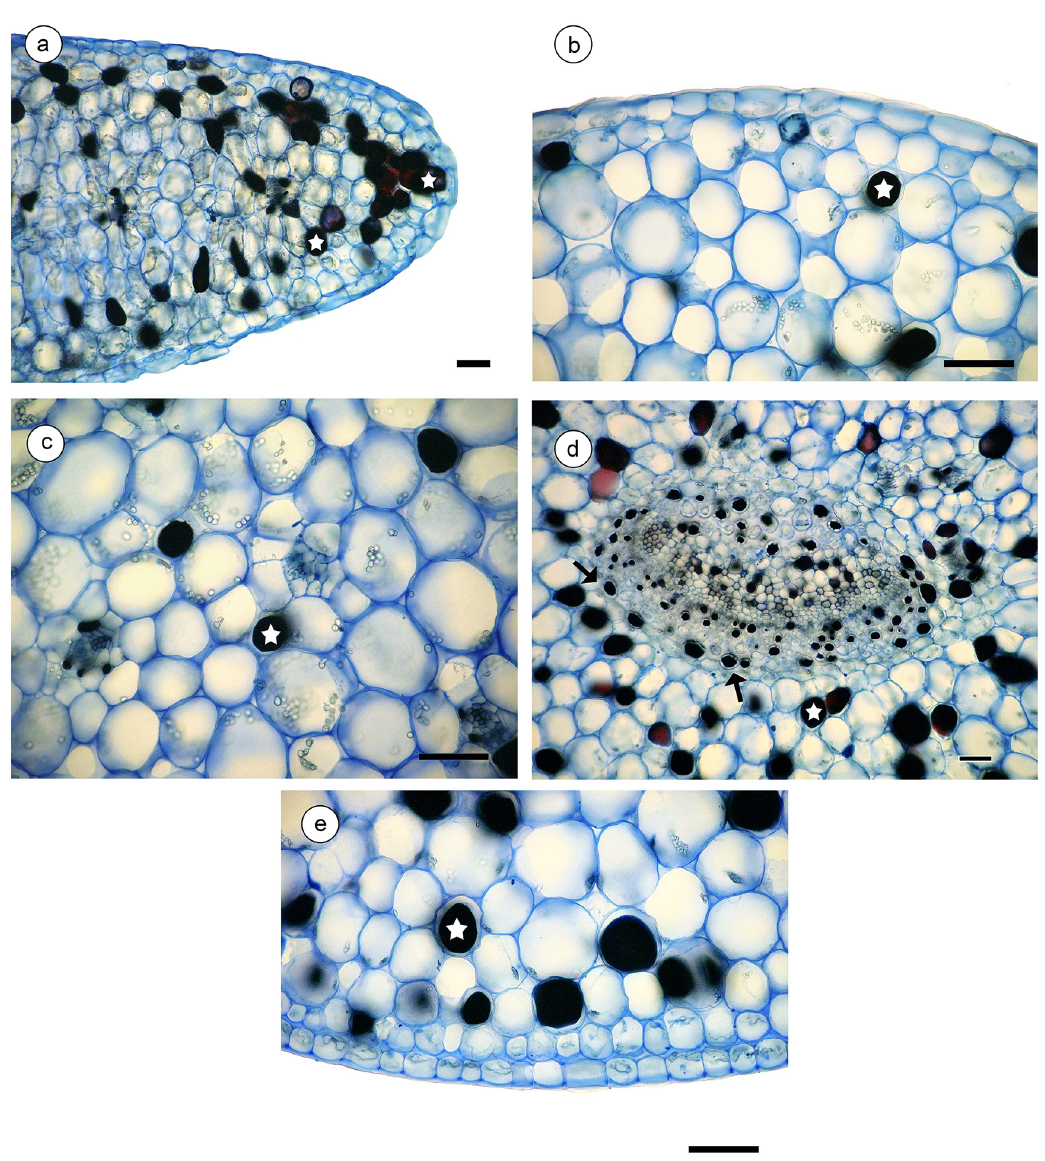
Fig. 3: Cross sections of Kalanchoe fedtschenkoi leaves. a - leaf blade margin at the middle third, b - e – petiole at the median region: adaxial surface (b); small caliber vascular bundles (c); main vascular bundle (d); abaxial side (e); parenchyma with thickened wall (black arrows); idioblasts with reddish brown content (stars). Bars 100